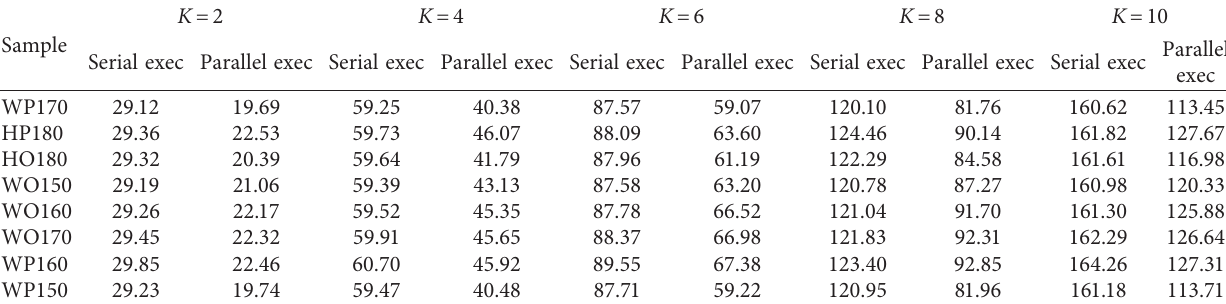
Table 7: Serial v/s parallel execution time (sec) for 1FT condition.